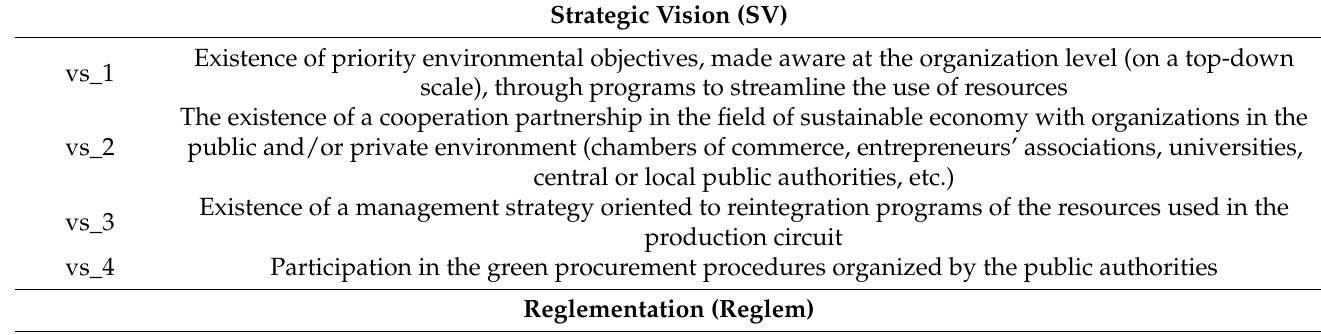
Table 1. Description of the independent variables in the model Strategic Vision